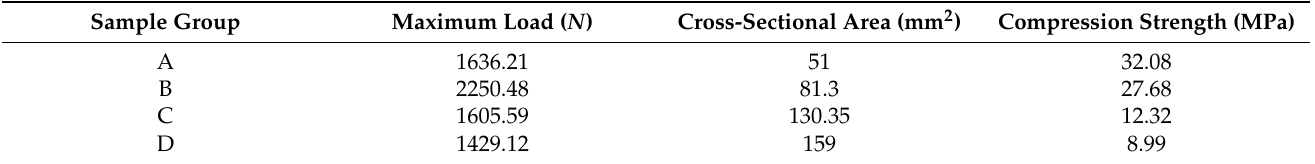
Table 8. The weft compression strength of four groups of samples.